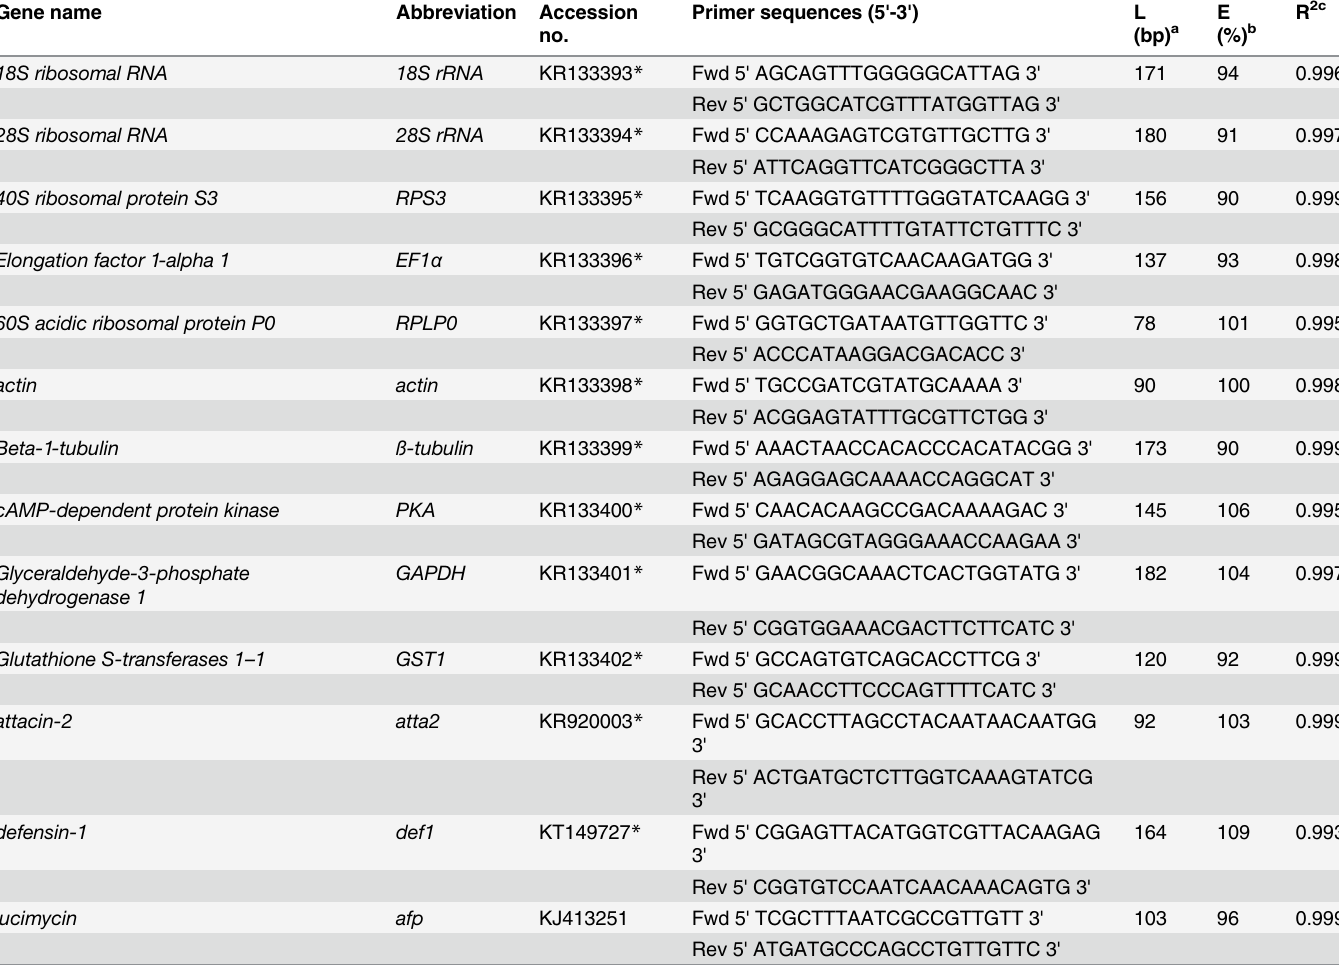
Table 1. Genes and qRT-PCR primers evaluated in this